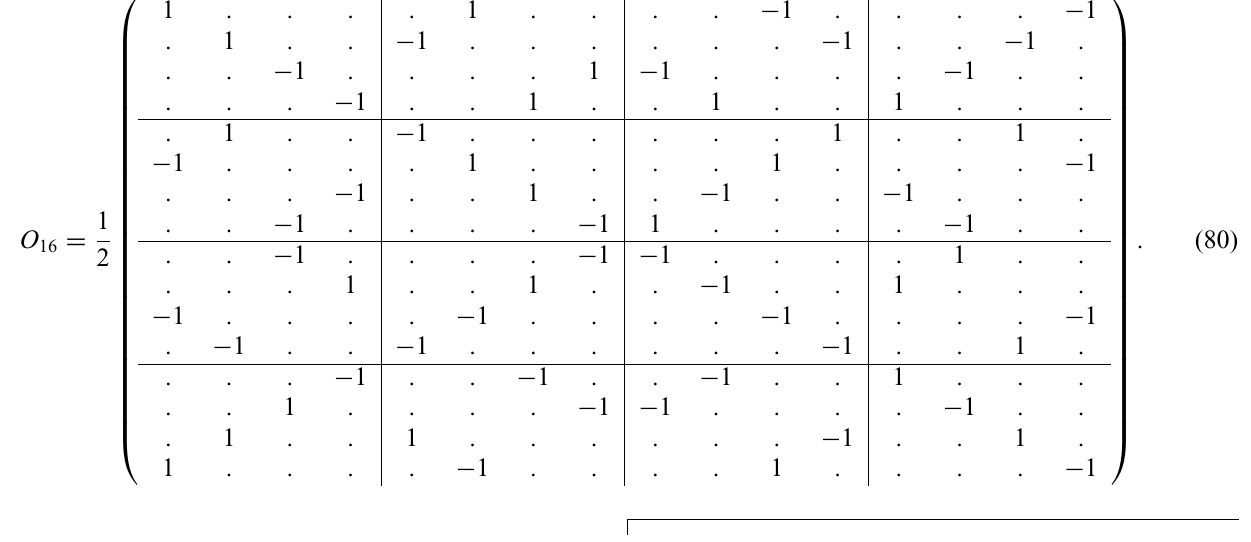
Eq. (66). Also note that each 4 × 4 block in Eq. (80) is